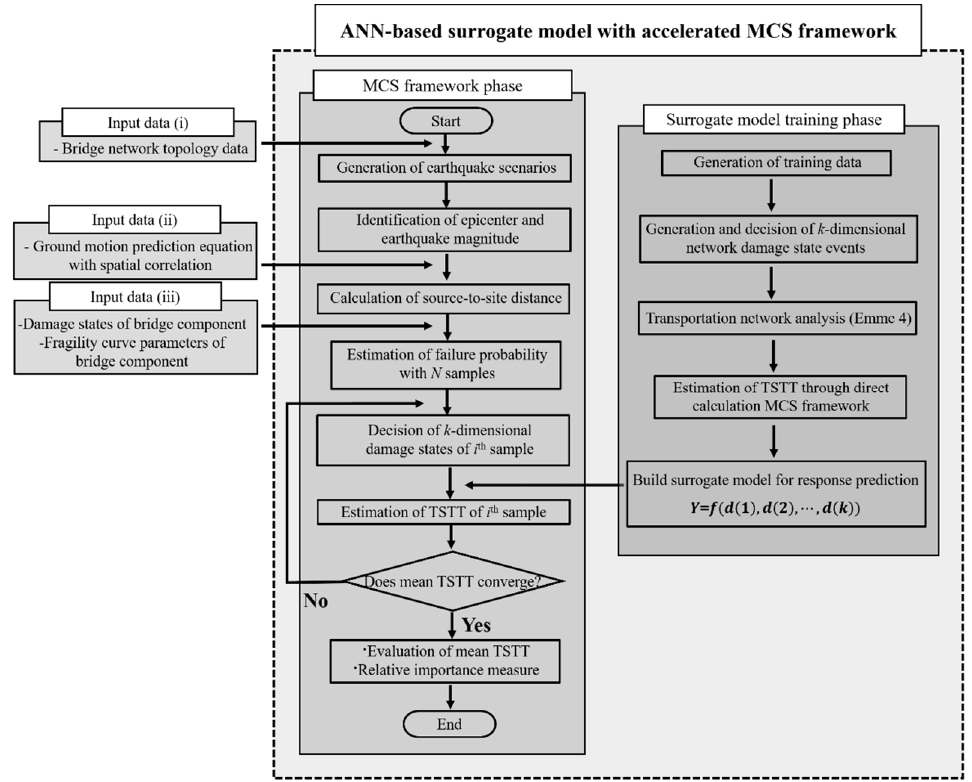
Figure 2. Flowchart for accelerated seismic risk assessment of bridge transportation networks.